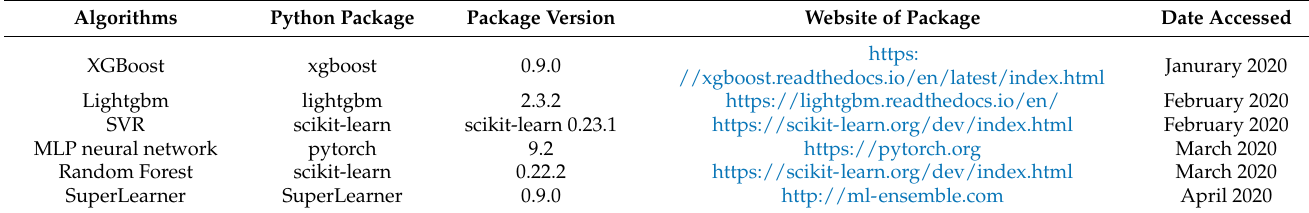
Table 3. Machine learning methods and their